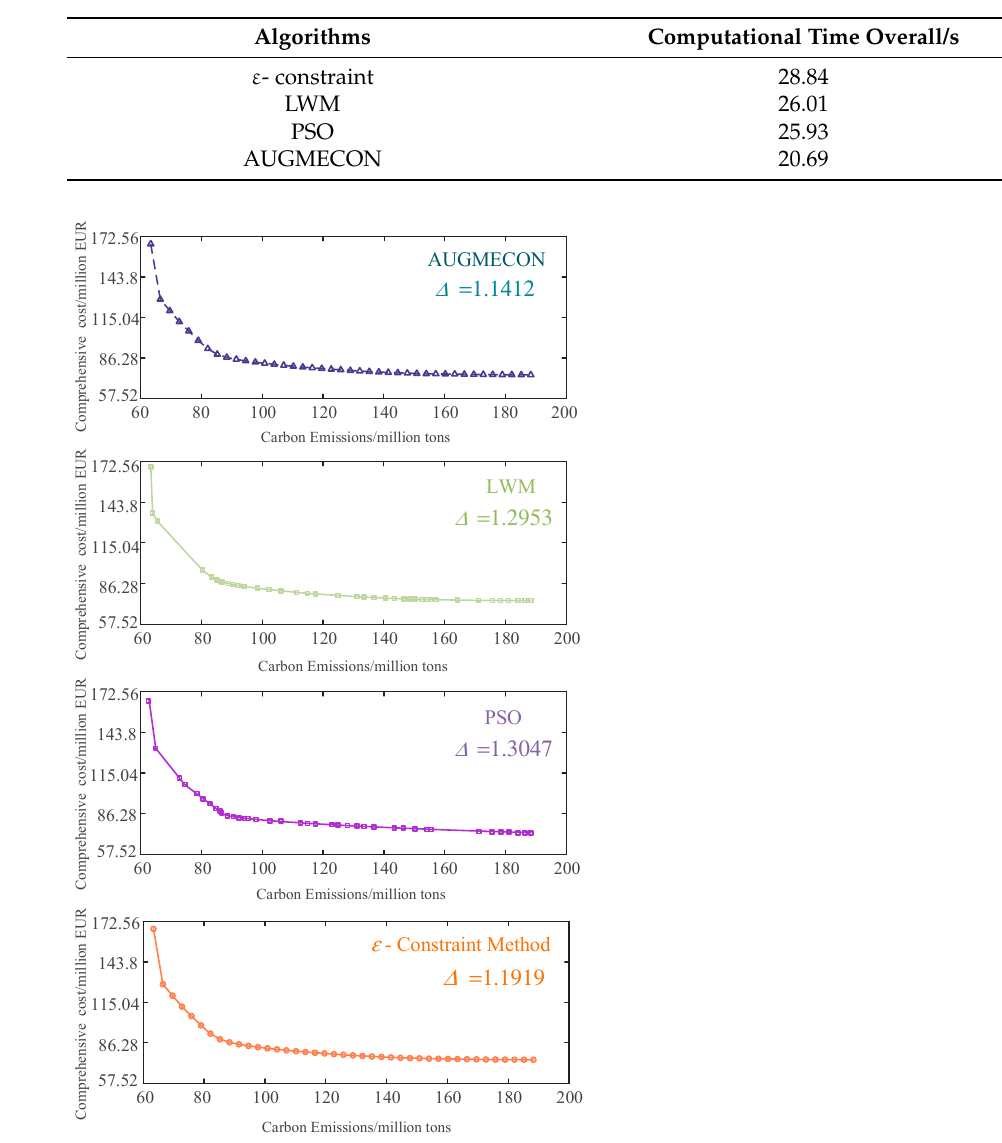
Table 7. Comparison of Multi-objective Algorithms.